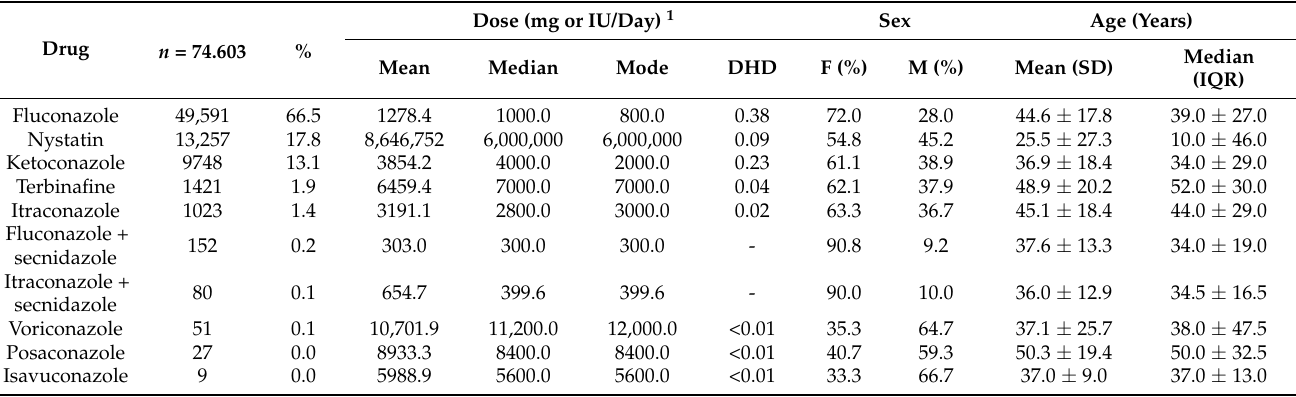
Table 1. Prescription patterns, frequency of use, dose, defined daily dose, and the distribution by sex and age in outpatients with systemic antifungal dispensations, Colombia.